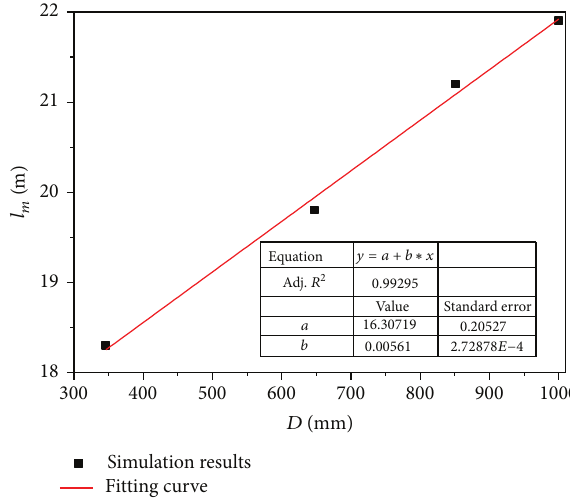
Figure 9: The maximum gas mixture length ( 𝑙 𝑚 ) versus the pipe diameter ( 𝐷